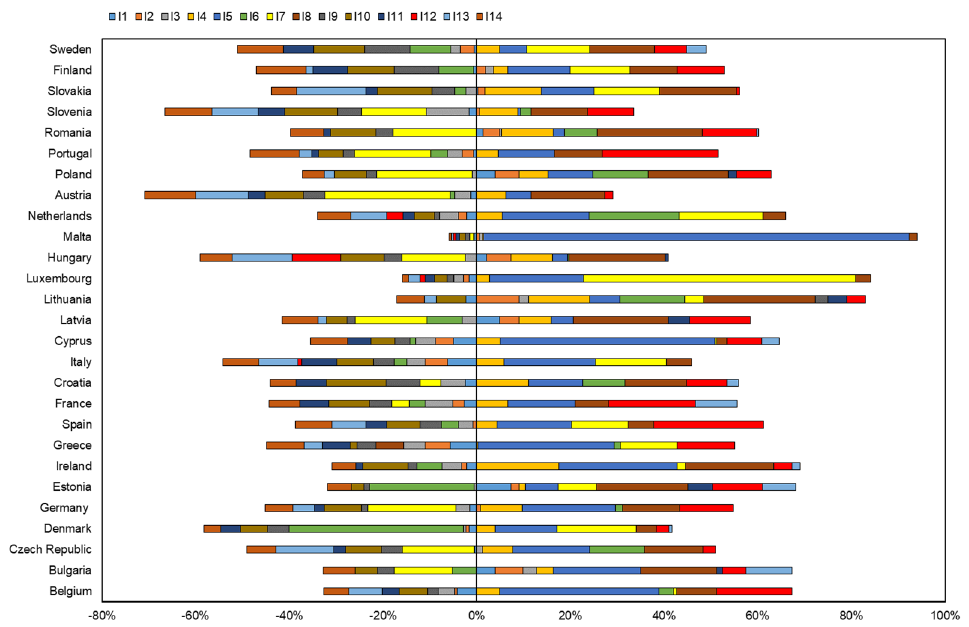
Figure 2. The percentage changes of the indicators of the EU sustainable energy and climate development between 2009–2018.